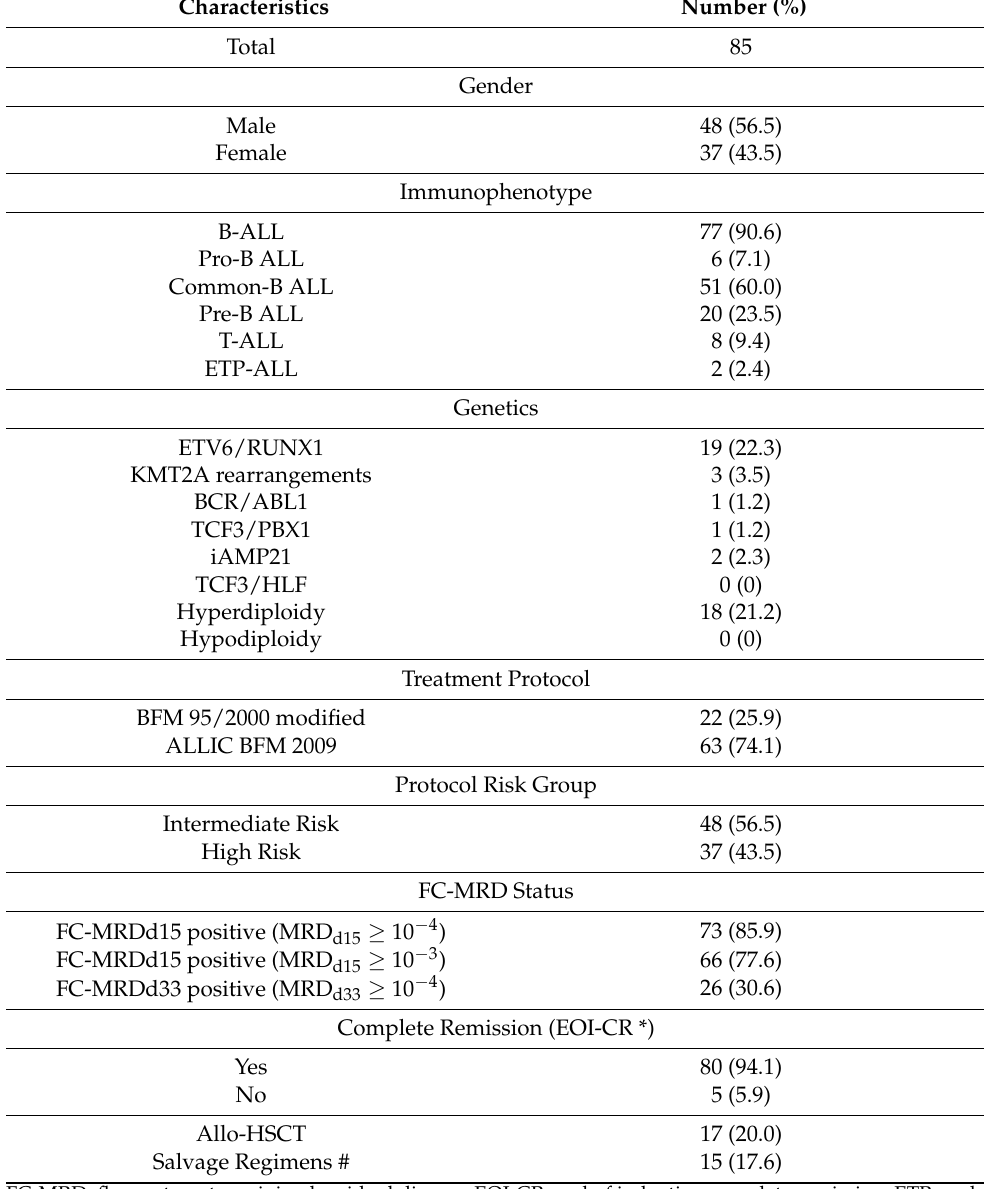
Table 1. Baseline demographic, clinical, immunophenotypic, genetic and treatment characteristics of ALL patients evaluated by